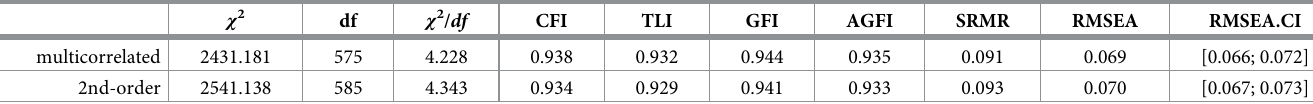
Table 2. Fit indexes of tested models in the validation of